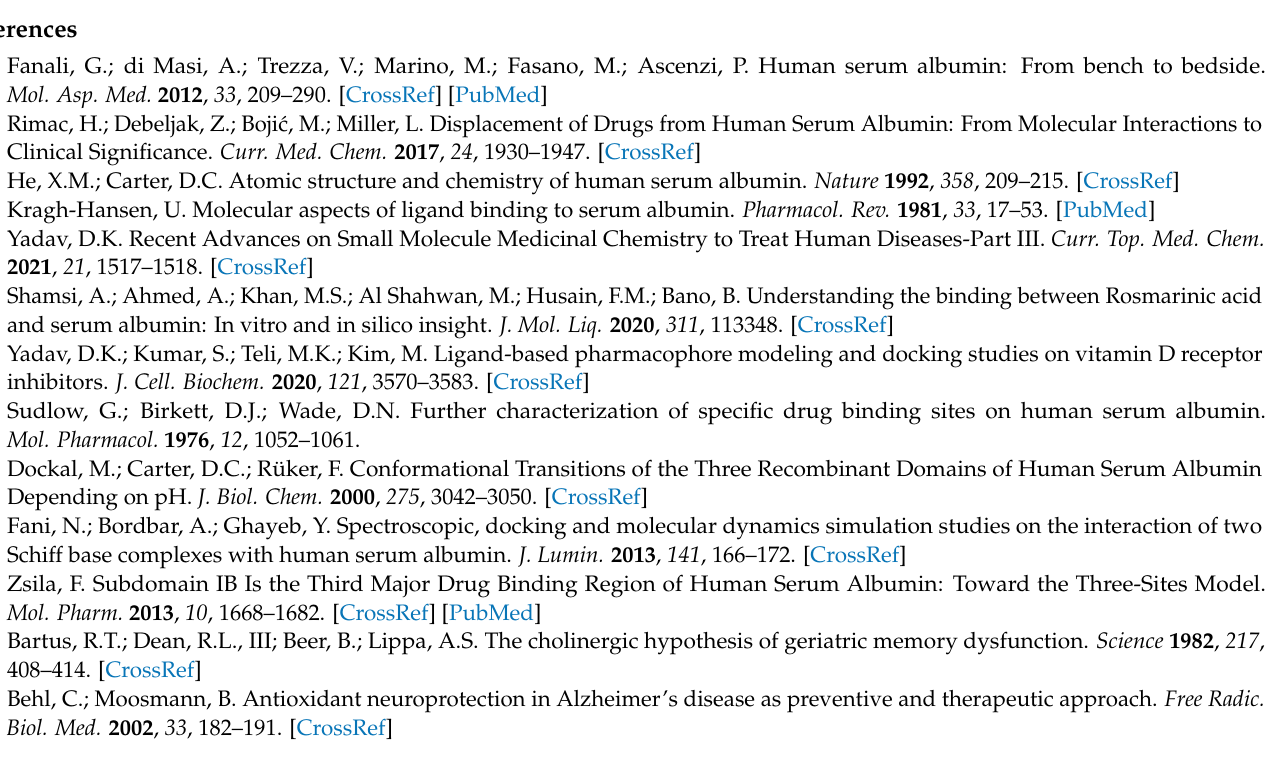
Figure S1: Molecular structure of Huperzine A: (A) 2D, (B) 3D stick, and (C) 3D ball and stick model of Huperzine A. Figure S2: Different docked conformations of HpzA with HSA. Figure S3: Energy table of different docked conformations of HpzA with